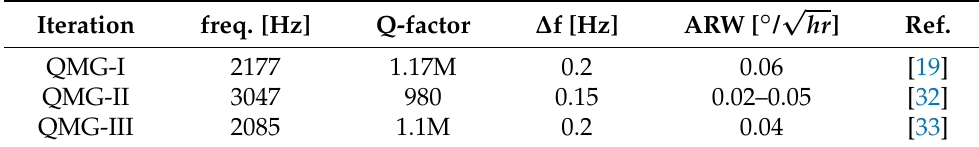
Table 1. Progression of QMG performance characteristics.